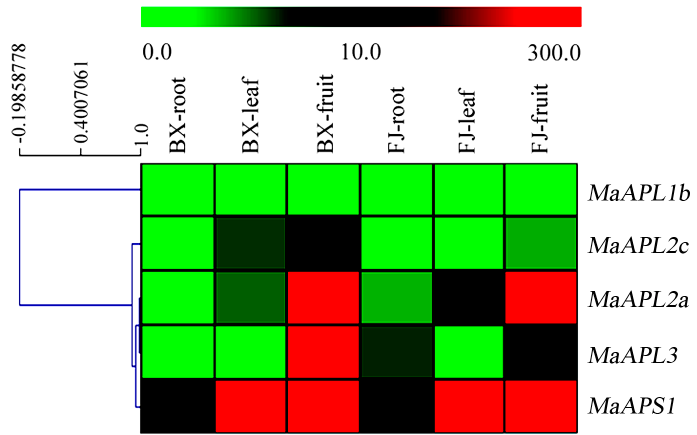
Figure 4. Expression of MaAGPases in roots, leaves, and fruits of BX and FJ banana varieties. The heat map with clustering was created based on the FPKM value of the MaAGPases . Differences in gene expression changes are shown in color in the green-red scale.